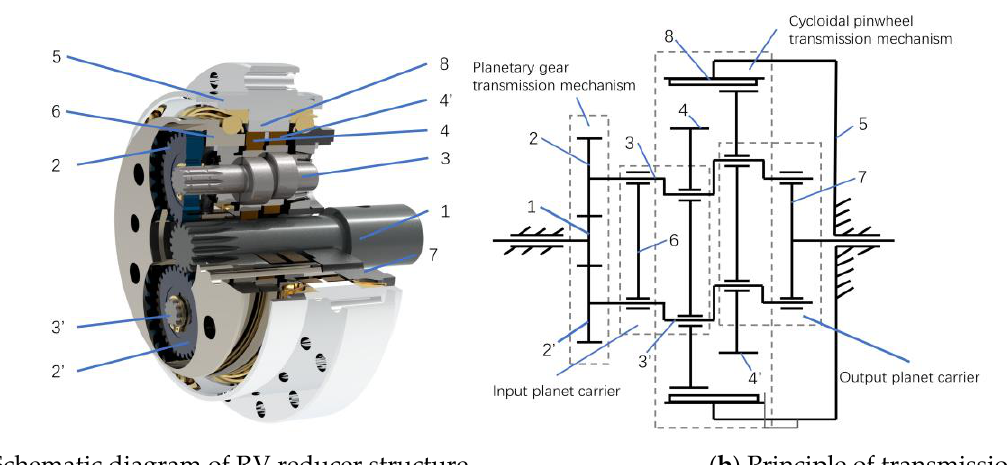
Figure 1. Structural schematic diagram of RV reducer. 1. Input shaft; 2. Planetary wheel; 3. Crankshaft; 4. Cycloid wheel; 5. Needle tooth shell; 6. Flange; 7. Planet carrier; 8. Needle gear.